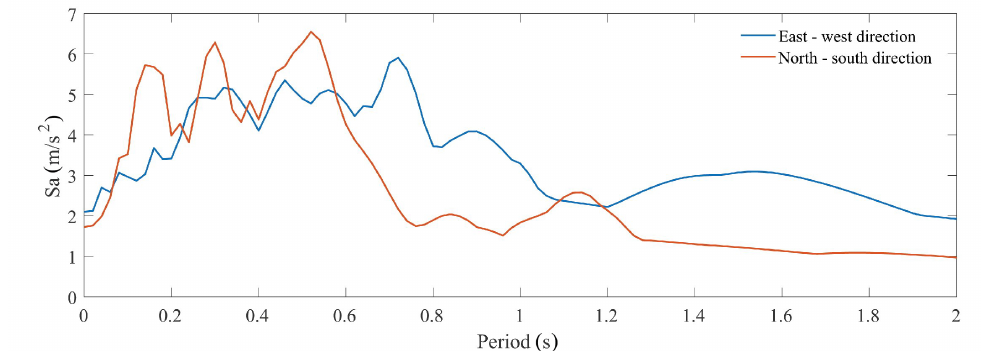
Figure 9. Acceleration response spectra of the Montenegro 1979 earthquake at the Albatros station for 5% damping ratio